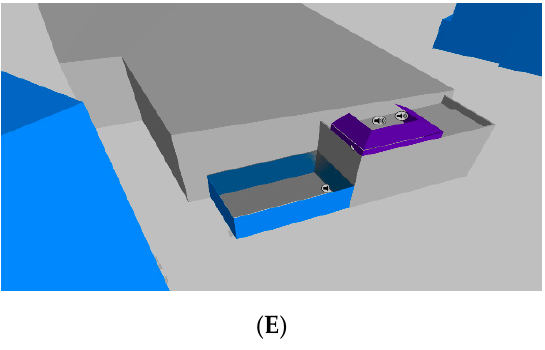
Figure 4. 3D model with the cooling systems, supply ramp and residential buildings (( A ) Scenario 1, ( B ) Scenario 2, ( C ) Scenario 3, ( D ) Scenario 4, ( E ) Scenario 5).